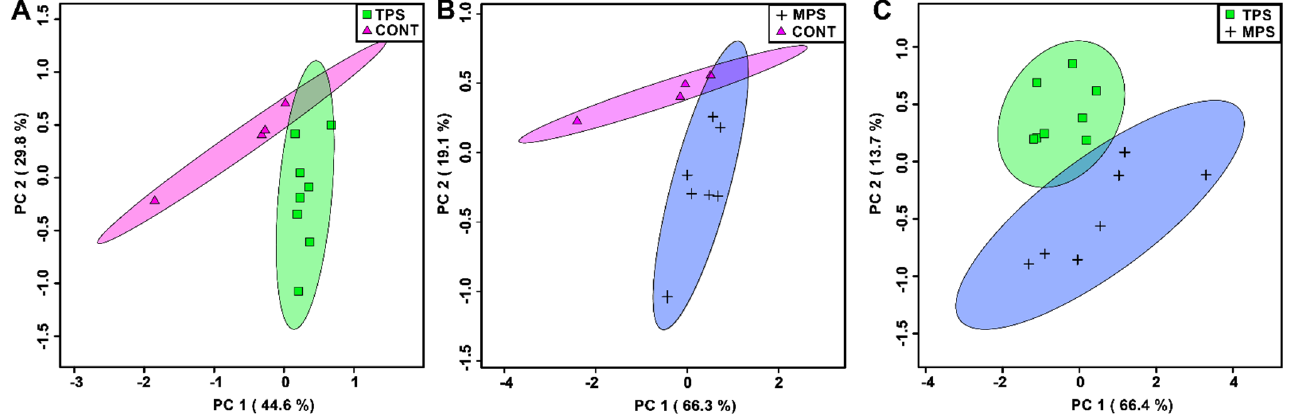
Figure 1. Principle component analysis (PCA) plots showing unsupervised separation between the groups: ( A ) transgenerationally stressed rats (TPS) vs. non-stressed controls (CONT); ( B ) multigenerationally stressed rats (MPS) vs. non-stressed controls (CONT); and ( C ) transgenerationally stressed rats (TPS) vs. multigenerationally stressed rats (MPS). Each PCA was carried out using only the bins that were determined to be significantly altered. Each point (triangle, cross, circle, or square) represents one individual based on the list of blood plasma metabolites found to be statistically significant via a Mann–Whitney U test and VIAVC analysis. Coloured ellipses represent 95% confidence intervals. X and Y axes show principal components 1 and 2, respectively, with brackets indicating the variance explained by each principal component. Note that the metabolomes of both TPS and MPS differed substantially from CONT and from each other. There were 144 total bins created. Of these bins, TPS vs. CONT, MPS vs. CONT, and TPS vs. MPS revealed eight, eight, and thirteen significantly altered bins, respectively.